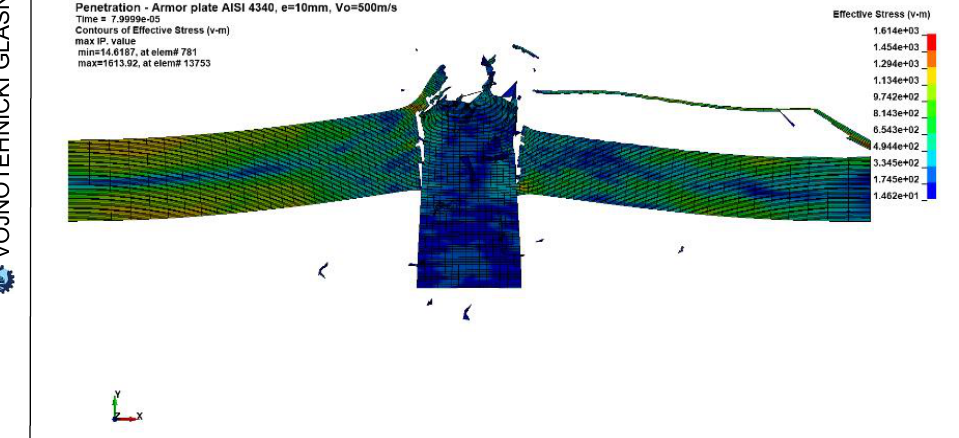
Figure 6 – Von Misses equivalent stress, time of analysis 0.07 ms – Model 1 Рис. 6 – Von Misses эквивалентное напряжение, время анализа 0.07 ms – Модель 1 Слика 6 –Von Misses-ов еквивалентни напон, време анализе 0,07 ms – модел